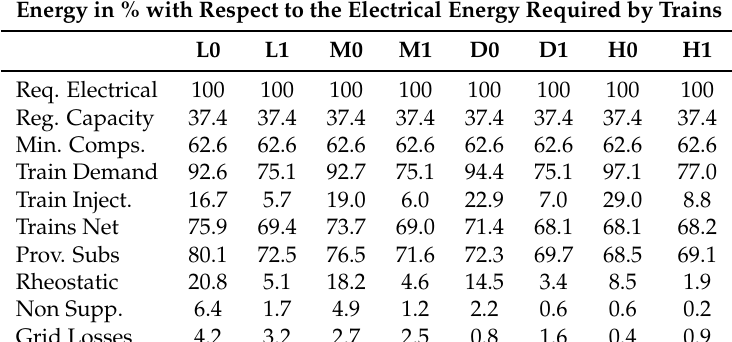
Table 5. Summary of the trains and the network in the different scenarios in (%).